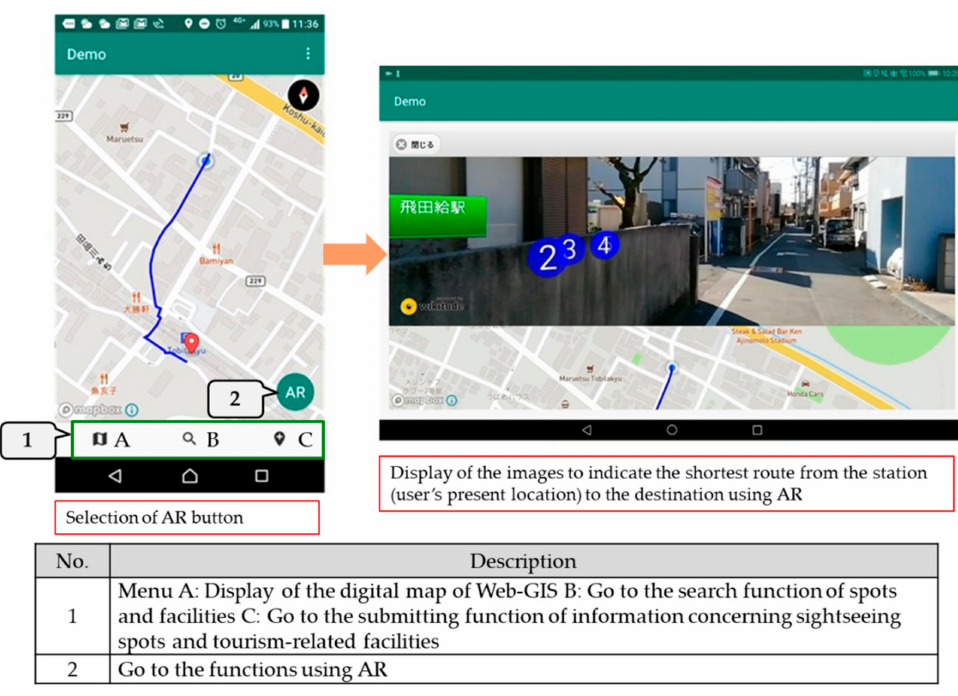
Figure 5. Screen for the navigation function using